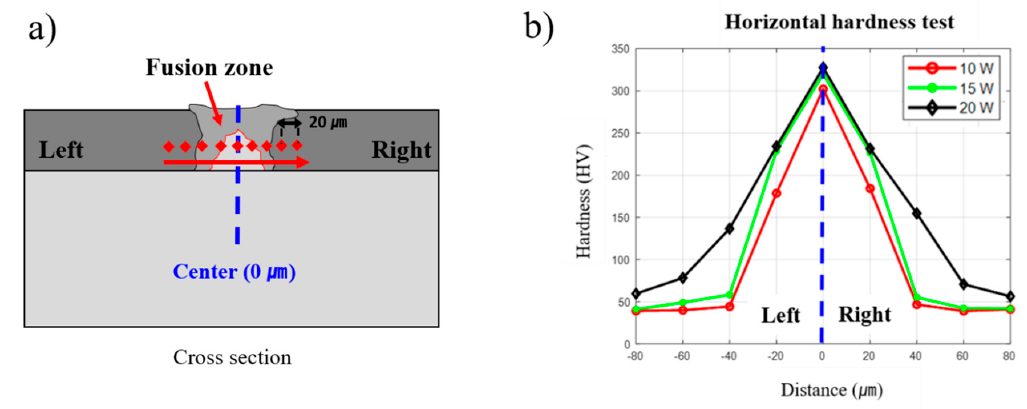
Figure 12. Hardness test on the horizontal direction in the FZ. ( a ) Schematic illustration of the test; ( b ) hardness profile at the laser power of 10 W, 15 W and 20 W.